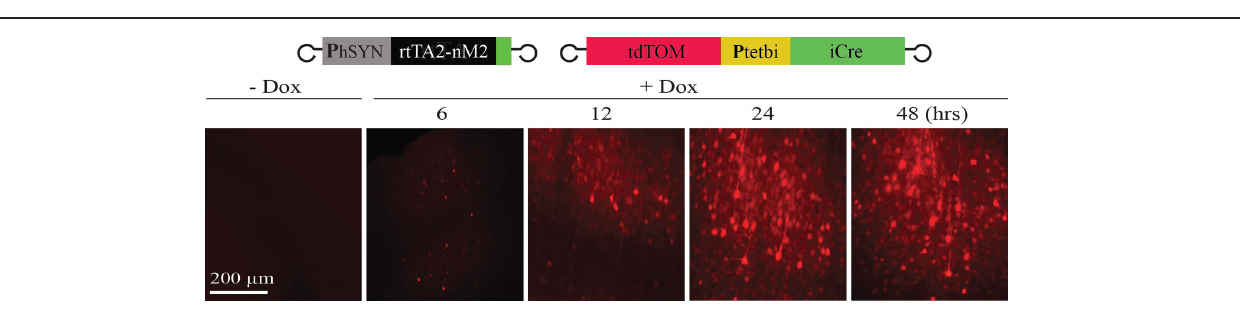
FIGURE 2 | P tet bi assisted inducible gene expression. (A) After Dox treatment, the P tet bi-iCre/tdTOM vector enabled robust tdTOM and iCre co-expression in an rtTA dependent manner (right), but not without Dox (left). Both tdTOM and iCre expression was colocalized in cortical neurons